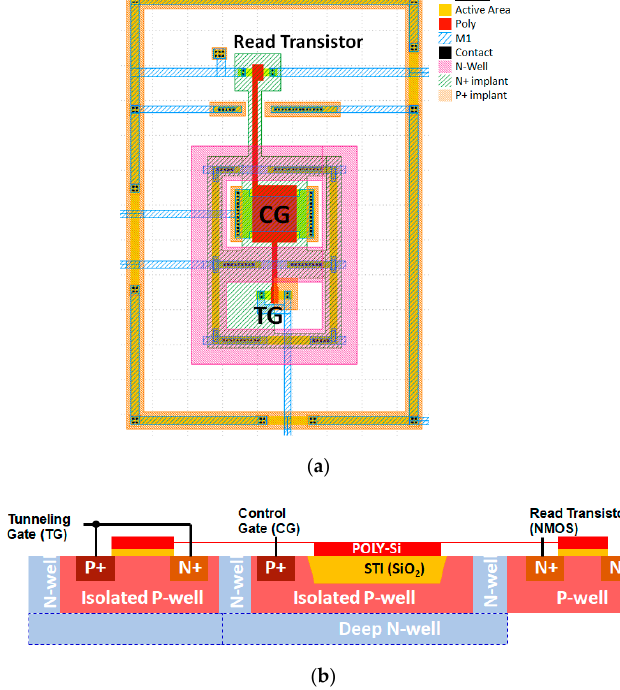
Figure 1. ( a ) C-Flash NVM cell layout. ( b ) C-Flash NVM cell cross-section.